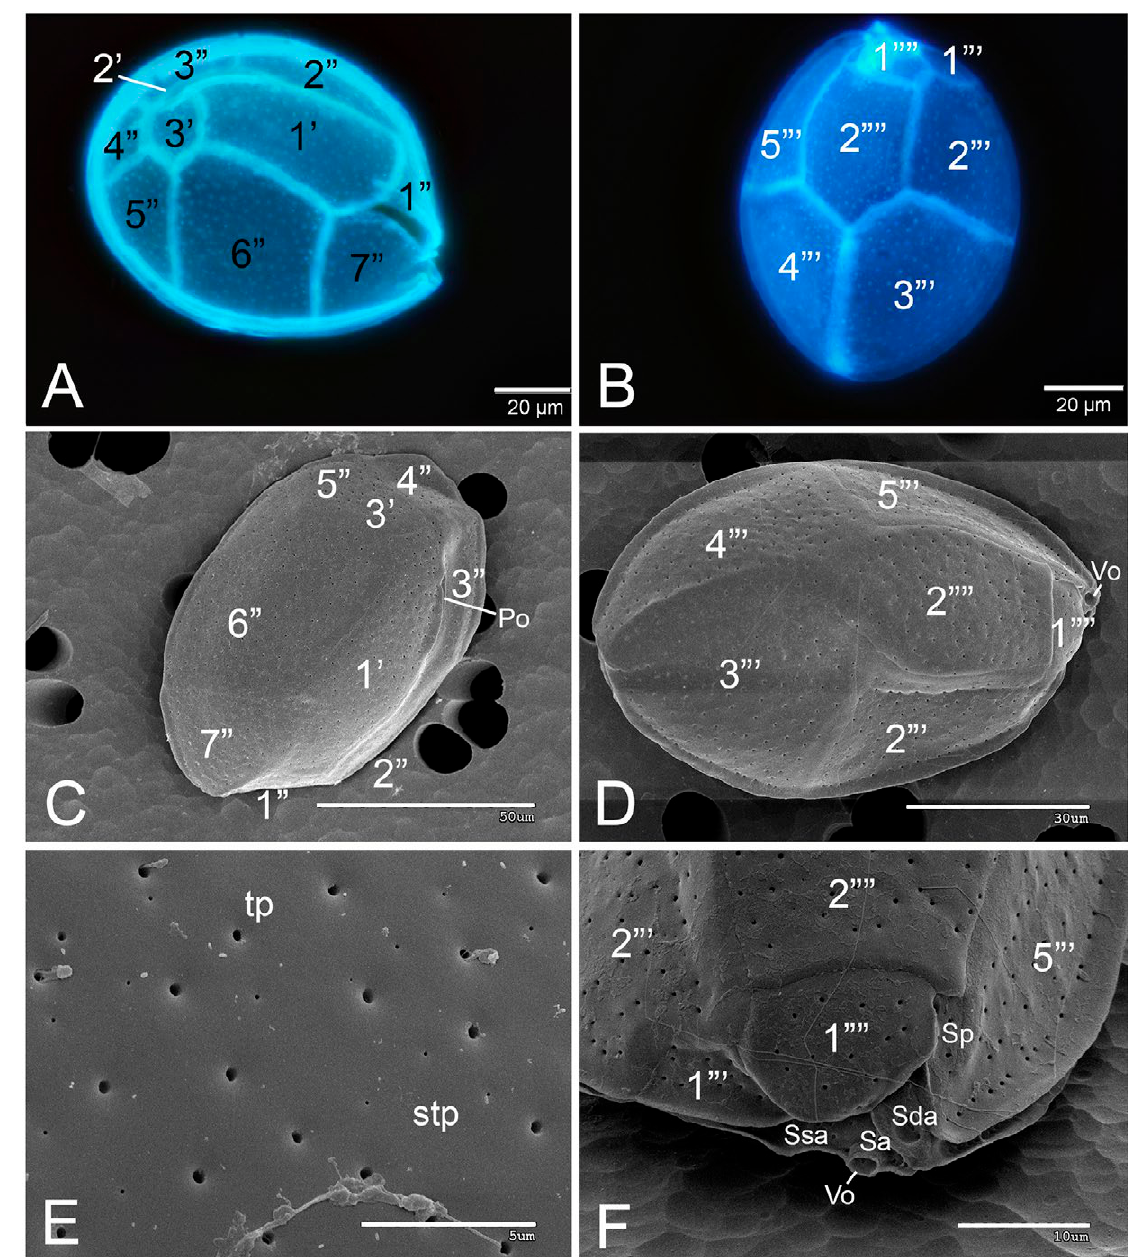
Fig. 5. – Thecal morphology of Ostreopsis lenticularis (strain 17G) (A and B, cells stained with Calcofluor White M2R viewed with epifluo- rescence microscopy; C-F, cells viewed with scanning electron microscopy). A and C, apical (epithecal) view; B and D, antapical (hypothecal) view; E, a fragment of a thecal plate, with the irregularly scattered trichocyst pores and small pores; F, a fragment of the hypotheca and the sulcal area. Plate labels: 1 ′ -3 ′ , the apical plates; 1 ″ –7 ″ , the precingular plates; 1 ′′′ -5 ′′′ , the postcingular plates; 1 ′′′′ and 2 ′′′′ , the antapical plates; Po, the apical pore plate; Sa, the anterior sulcal plate; Sda, the right sulcal plate; stp, small thecal pores; Sp, the posterior sulcal plate; Ssa, the left sulcal plate; tp, the trichocyst pores; Vo, the ventral opening (also known as the ventral pore). The plates are named according to Hoppenrath et al. (2014). Scale bars: 20 µm in A and B; 50 µm in C; 30 µm in D; 5 µm in E; 10 µm in